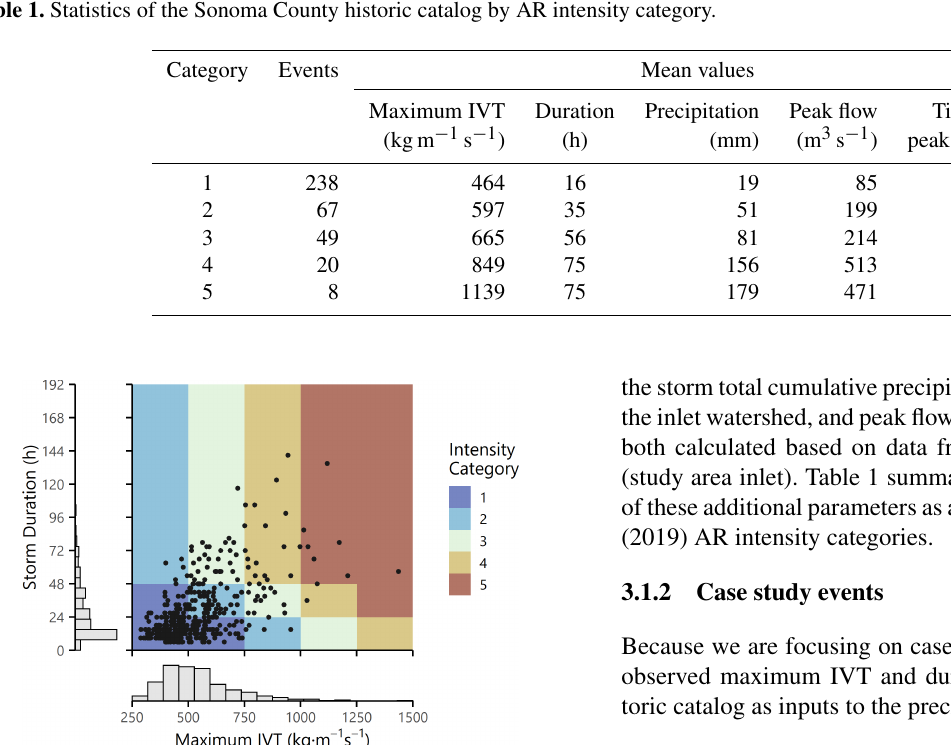
Table 1. Statistics of the Sonoma County historic catalog by AR intensity category.